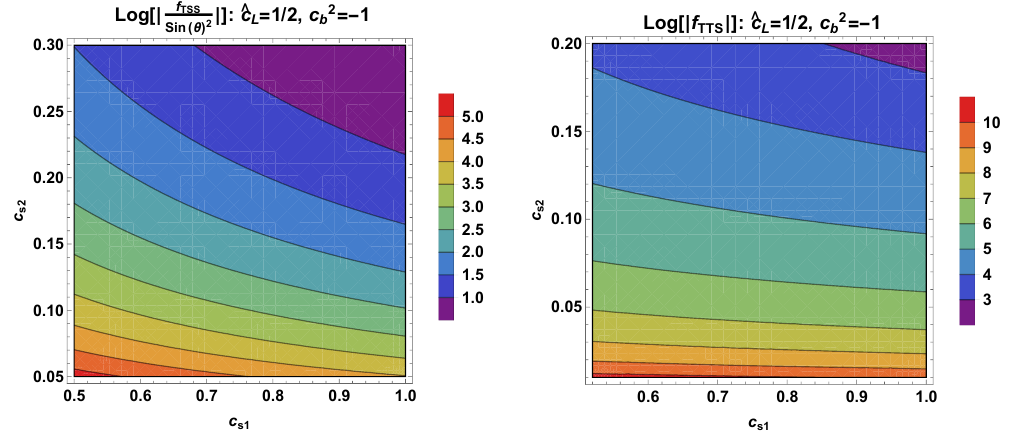
Figure 5 . On the left the dominant h R 2 On the right the dominant h 2 R considering (cid:15) ∼ 10 − 2 we get f (TTS) of order 10 3 / 10 4 in the region c